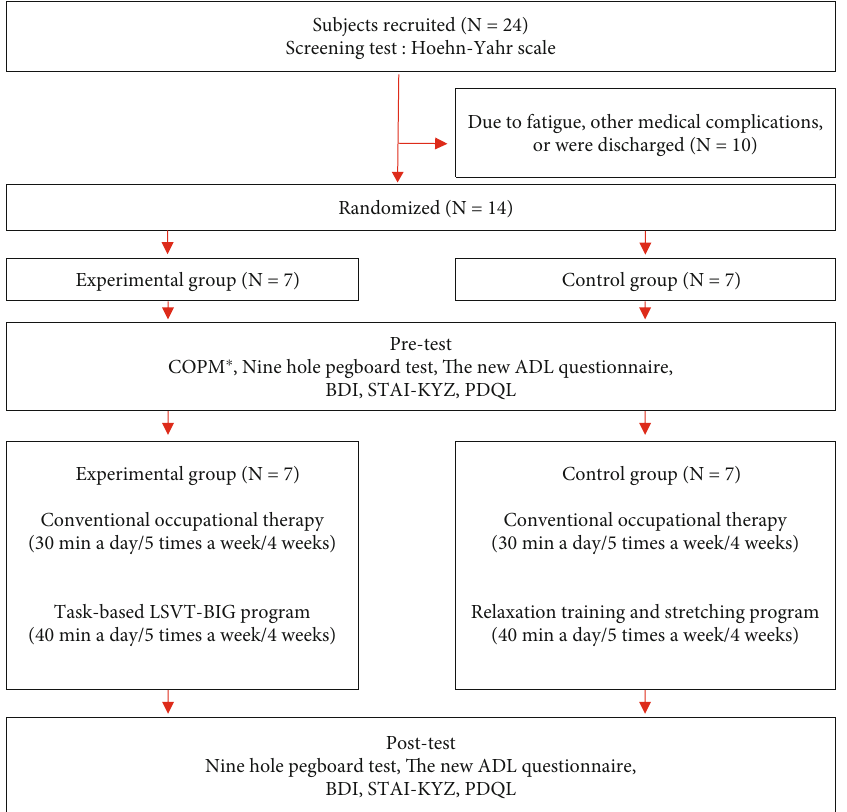
Figure 1: Flow chart. COPM: Canadian Occupational Performance Measure; BDI: Beck Depression Inventory; STAI-KYZ: State Trait Anxiety Inventory-Korean; PDQL: Parkinson ’ s Disease Quality of Life Questionnaire. ∗ COPM was conducted only in the experimental